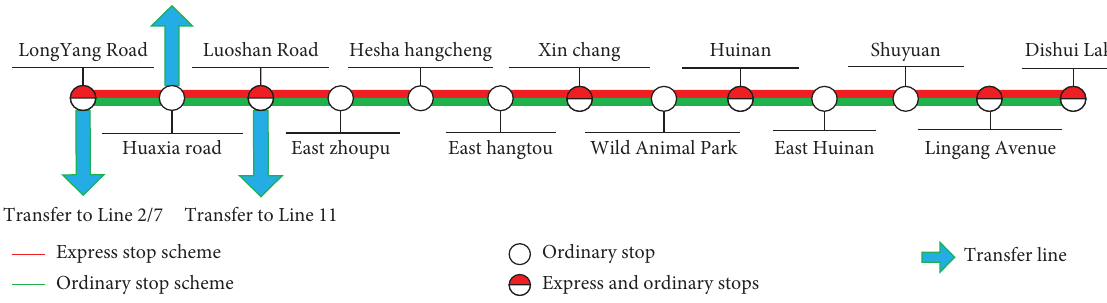
Figure 8: Schematic diagram of stop optimization scheme of Shanghai rail transit line